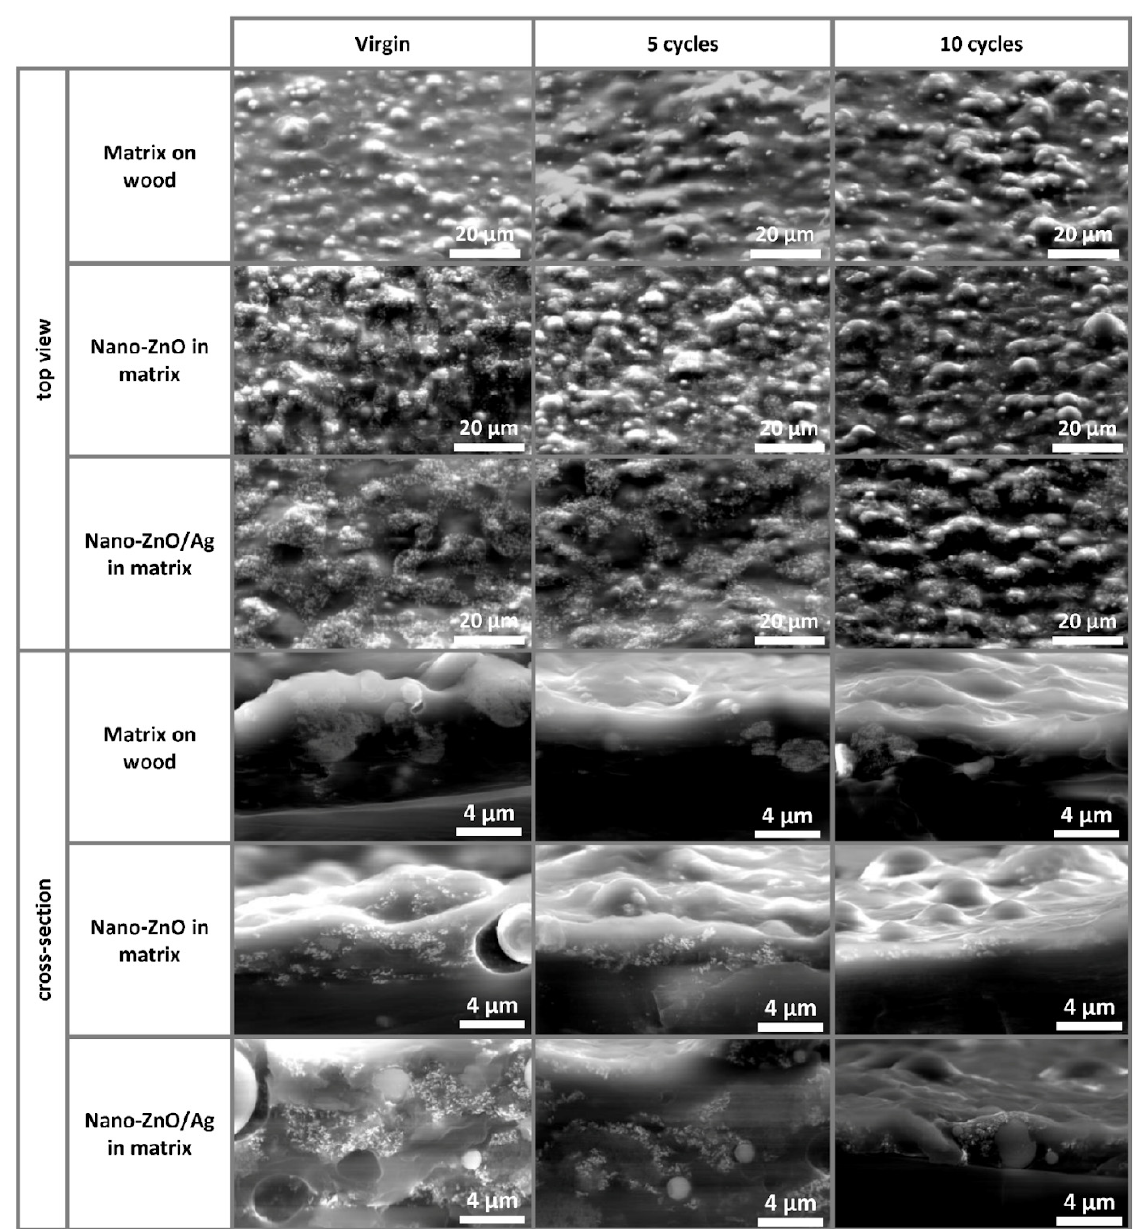
Figure 8. Scanning electron microscopy images of coatings on wooden substrates before (virgin) and after 5 and 10 reuse cycles. No apparent changes occurred to the coatings after reuse cycles and the embedded ZnO and ZnO/Ag nanoparticles were visible both in top view and cross-section images.